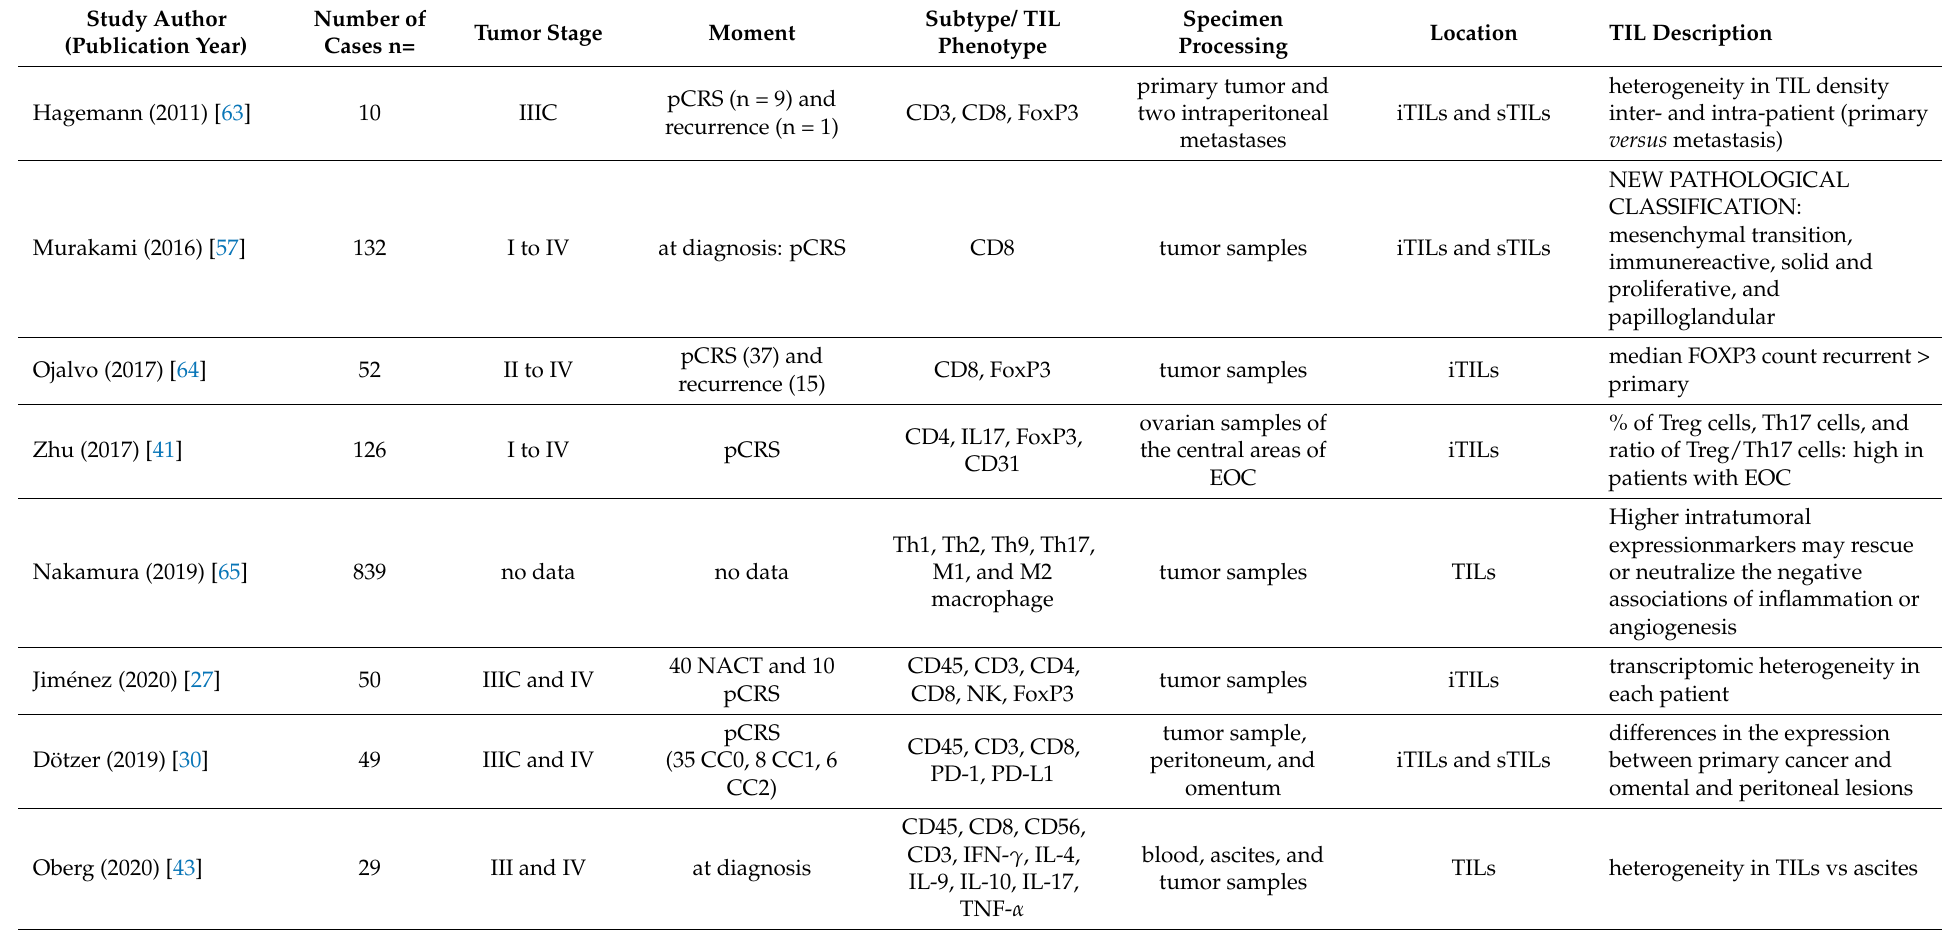
Table 1. TIL phenotypes in the reviewed